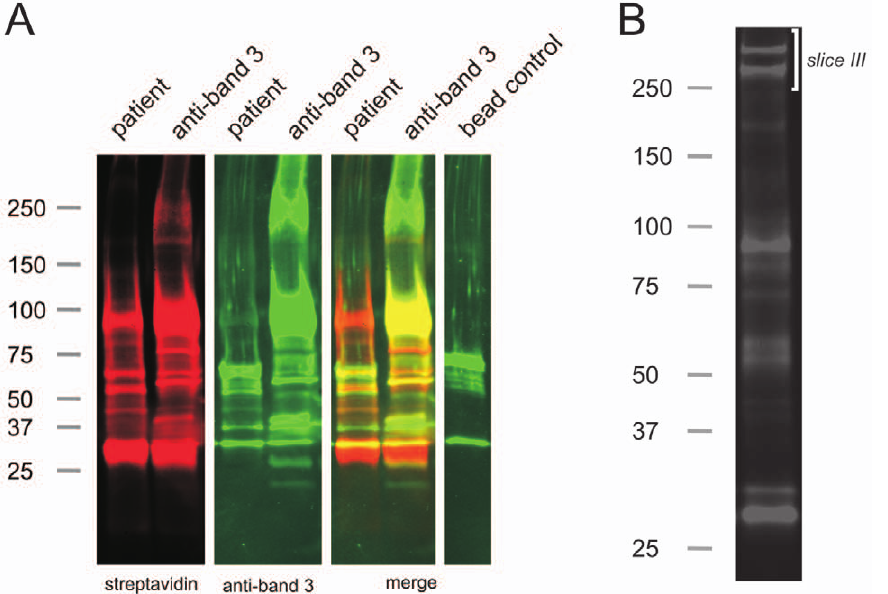
Figure 3. Erythrocyte autoantibody immunoprecipitation of biotinylated erythrocyte vesicles from a 35 day old transfusion unit. (A) Immunoprecipitation with either plasma from patient No. 2, or a monoclonal antibody against band 3 (see Materials and Methods). Analysis was performed by SDS-PAGE, followed by detection of biotinylated membrane proteins (red, streptavidin) and band 3 (green, polyclonal rabbit antibody). A protein G bead control was included. (B) Example immunoprecipitation of biotinylated erythrocyte vesicles from a 35 day old transfusion unit using plasma from patient No. 1. Analysis was performed by SDS-PAGE, followed by detection of biotinylated membrane proteins using fluorochrome conjugated streptavidin. The same sample was used for Coomassie blue gel staining and subsequent proteomics analysis (Table 2). The gel slice which was excised for proteomic analysis is indicated as slice III (see also Table S1). Numbers indicate approximate molecular weight (kDa). Blots were analyzed using the Odyssey Infrared Imaging System.